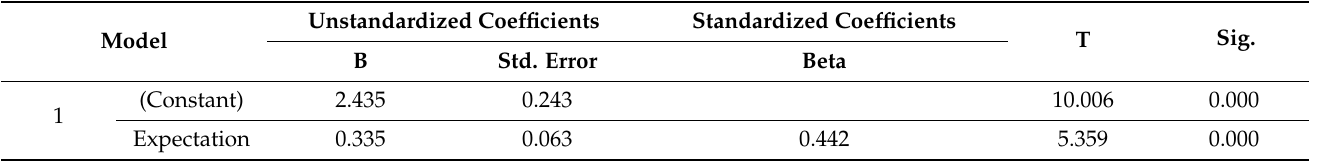
Table 6. Impact of expectation of benefits on job satisfaction